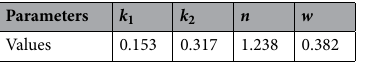
Table 3. Damage model parameters of